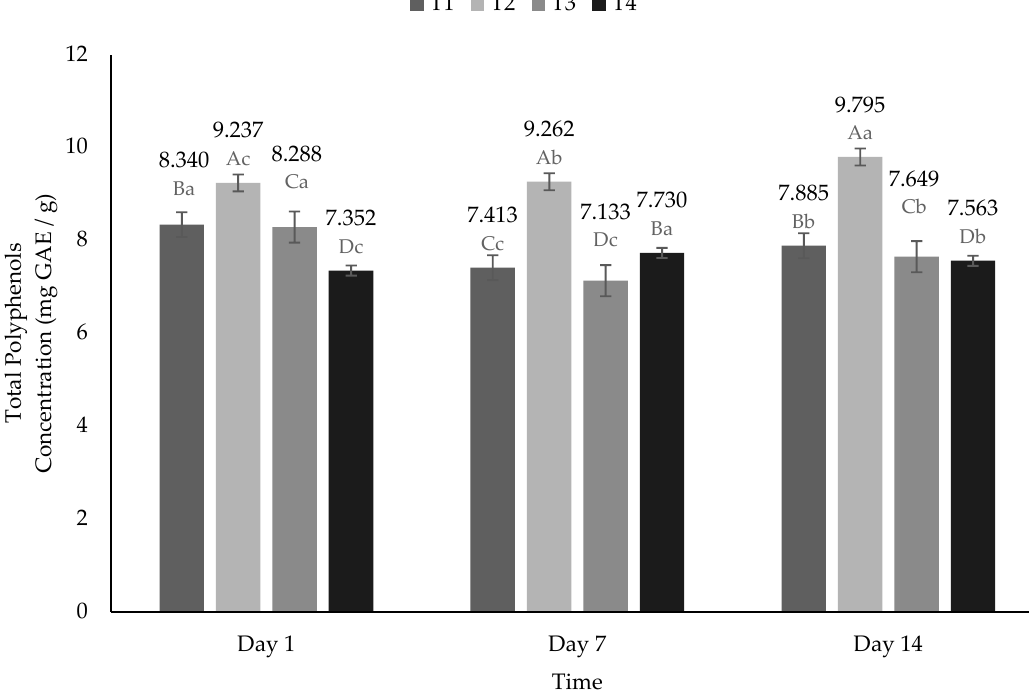
Figure 5. Total polyphenol content of yogurt added with beet extract. T1 = Natural yogurt (Y), T2 = Y added with beet juice, T3 = Y added with extract encapsulated with Maltodextrin, and T4 = Y added with extract encapsulated with Inulin. A,B,C,D Values with different superscript indicate significant statistical difference between treatments ( p < 0.05). a,b,c Values with a different superscript indicate significant statistical difference over time ( p < 0.05).